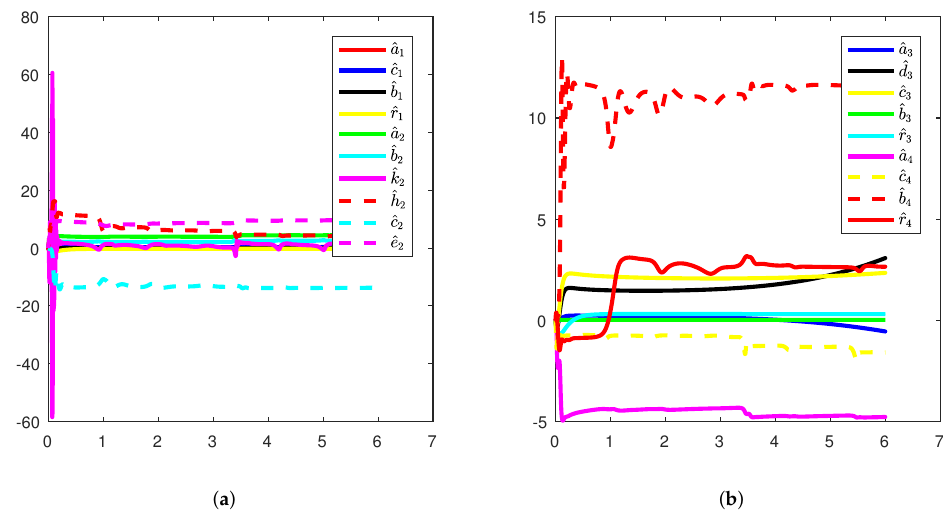
Figure 4. ( a , b ): Time response of estimated values of parameters ˆ a 1 , ˆ c 1 , ˆ b 1 , ˆ r 1 , ˆ a 2 , ˆ b 2 , ˆ k 2 , ˆ h 2 , ˆ c 2 , ˆ e 2 of drive systems (35) ˆ a 3 , ˆ d 3 , ˆ c 3 , ˆ b 3 , ˆ r 3 , ˆ a 4 , ˆ c 4 , ˆ b 4 , ˆ r 4 of response system